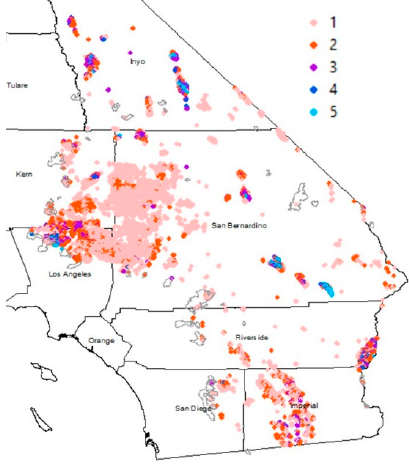
Figure 6. Map of breakpoints detected from structural change analysis of LST between 2000 and 2018 for MODIS 1-km monthly time series. All Monitoring Trends in Burn Severity (MTBS) wildfire boundaries since the year 2000 are shown as gray outlines. Number of breakpoints per pixel shown in the color legend (upper